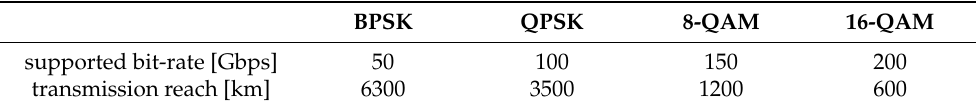
Table 1. Supported bit-rate and transmission distance for a transponder operating within 37.5 GHz